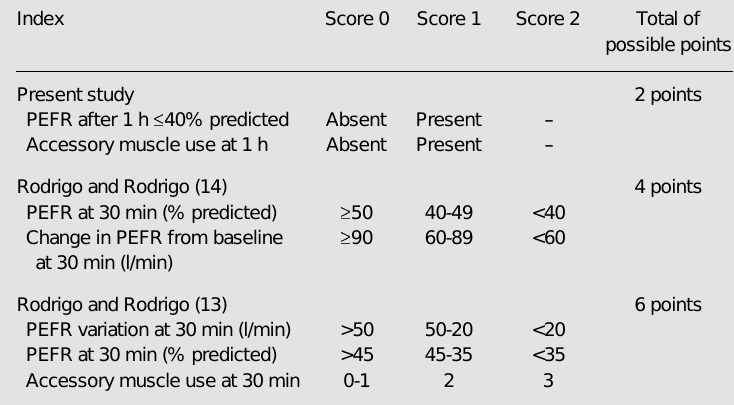
Table 3. Comparison between the indices.